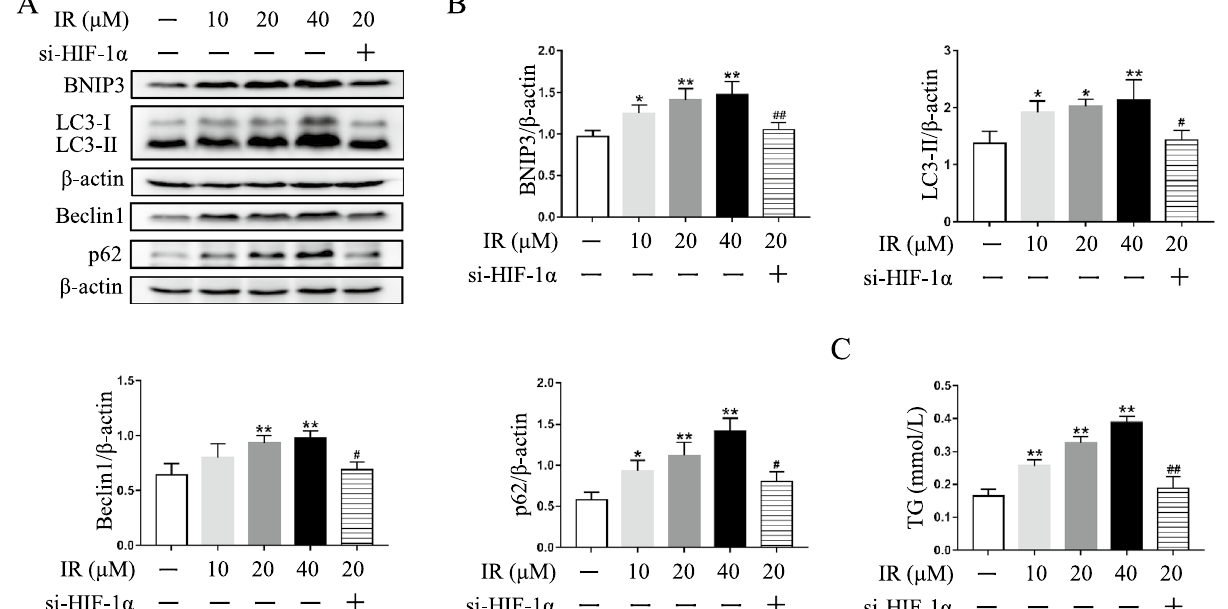
Figure 5. HIF-1α siRNA mitigates autophagosome accumulation and lipid deposition in irinotecan (IR)- treated HepG2 cells. ( A ) Western blot analysis of BNIP3, LC3-II, Beclin1 and p62 protein levels in HepG2 cells. ( B ) Densitometric quantification of BNIP3, LC3-II Beclin1 and p62. ( C ) IR exacerbated TG content in HepG2 cells and co-treated with HIF-1α siRNA decreased cellular TG content. The blots were cut prior to hybridisation with indicated primary antibodies. Data are presented as mean ± SD (n = 3), * P < 0.05 and ** P < 0.01 compared with normal control group, # P < 0.05 and ## P < 0.01 compared with 20 μM IR-treated group.